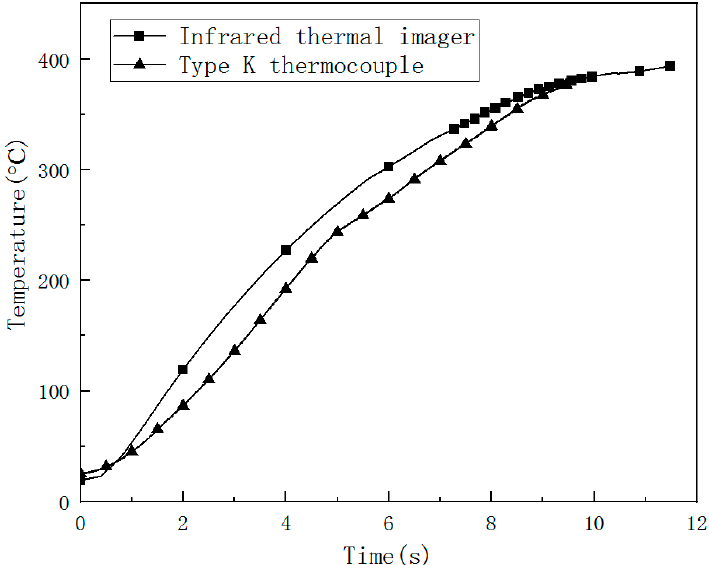
Figure 12. The center temperature of CFRP laminated back surface measured by IR camera and K type thermocouple (500 W, irradiation time 10 s).